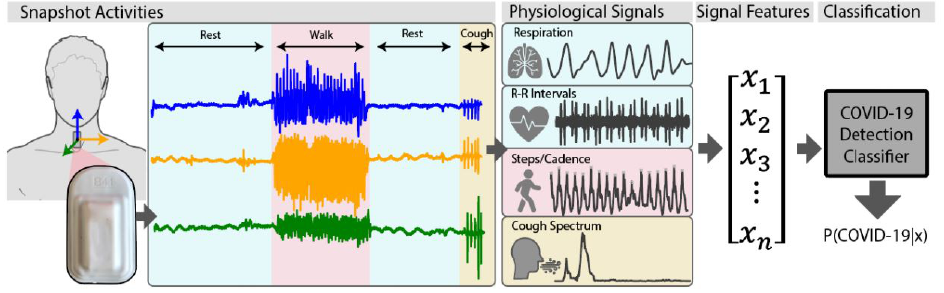
Figure 9. COVID-19 detection classifier using physiological signals [46].